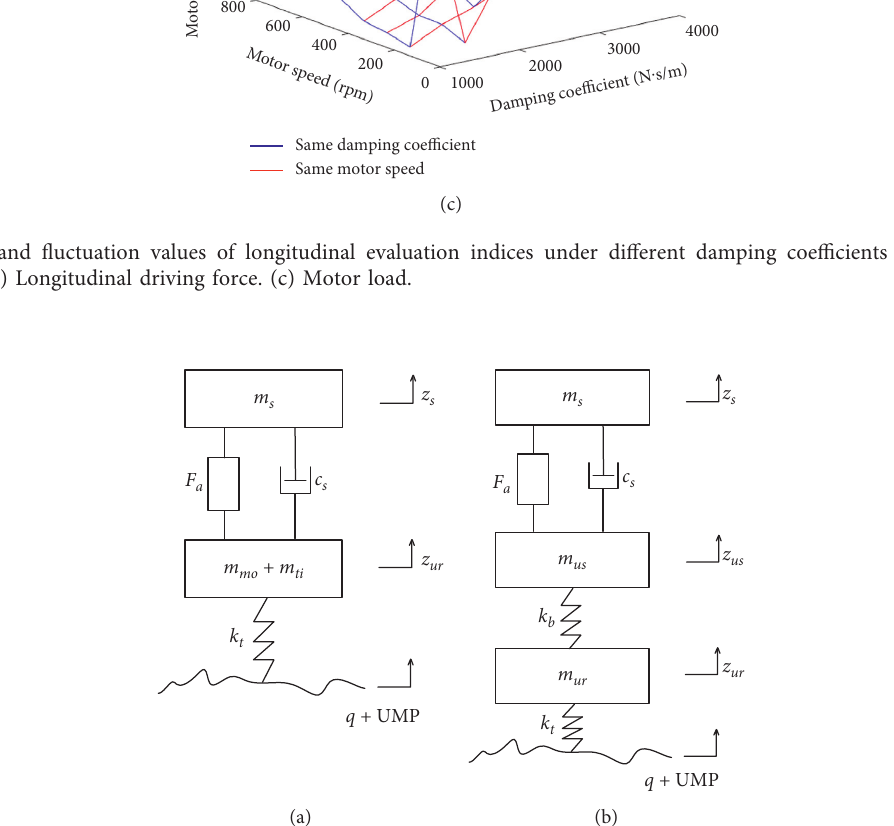
Figure 13: Traditional electric wheel and suspension-integrating model. (a) Two-DOF quarter car model. (b) Three-DOF quarter car